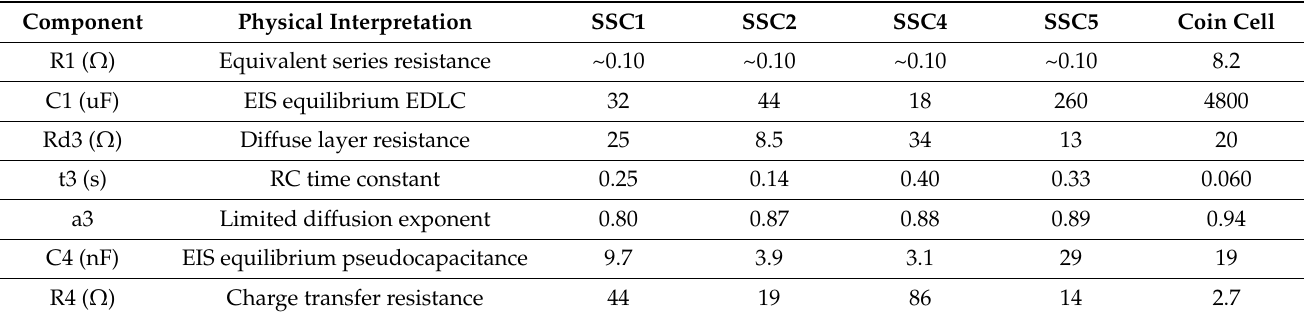
Table 2. Equivalent circuit component